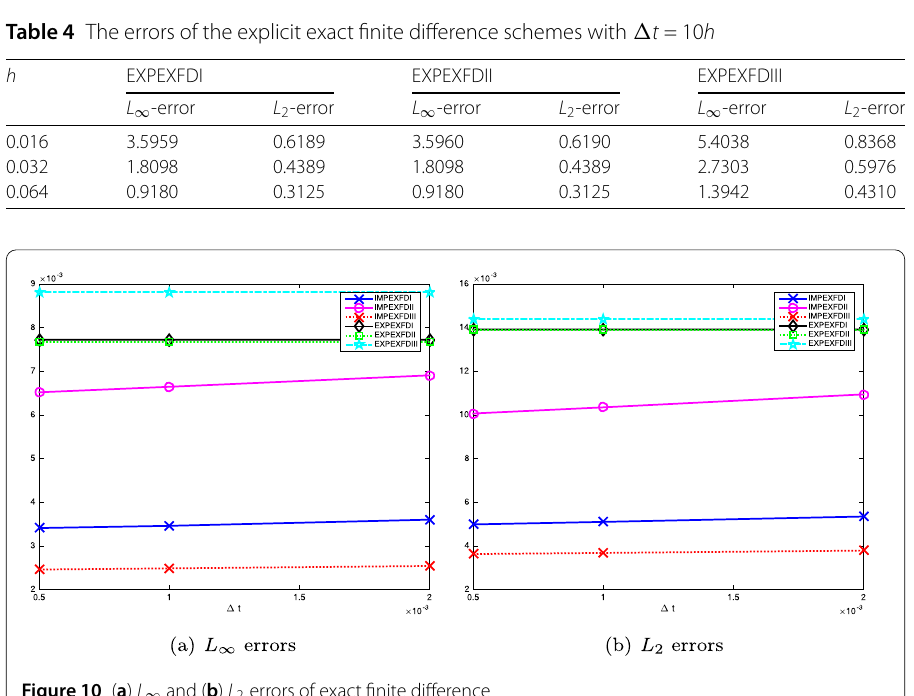
Figure 10 ( a ) L ∞ and ( b ) L 2 errors of exact finite difference